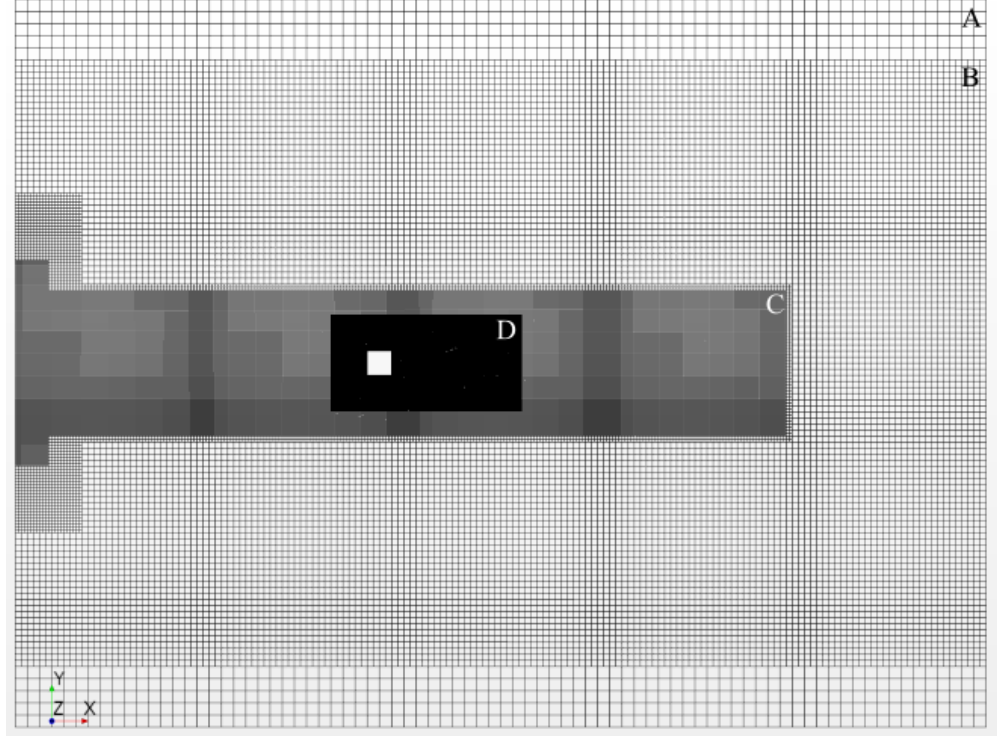
Figure 4. Overall mesh viewed at cylinder center